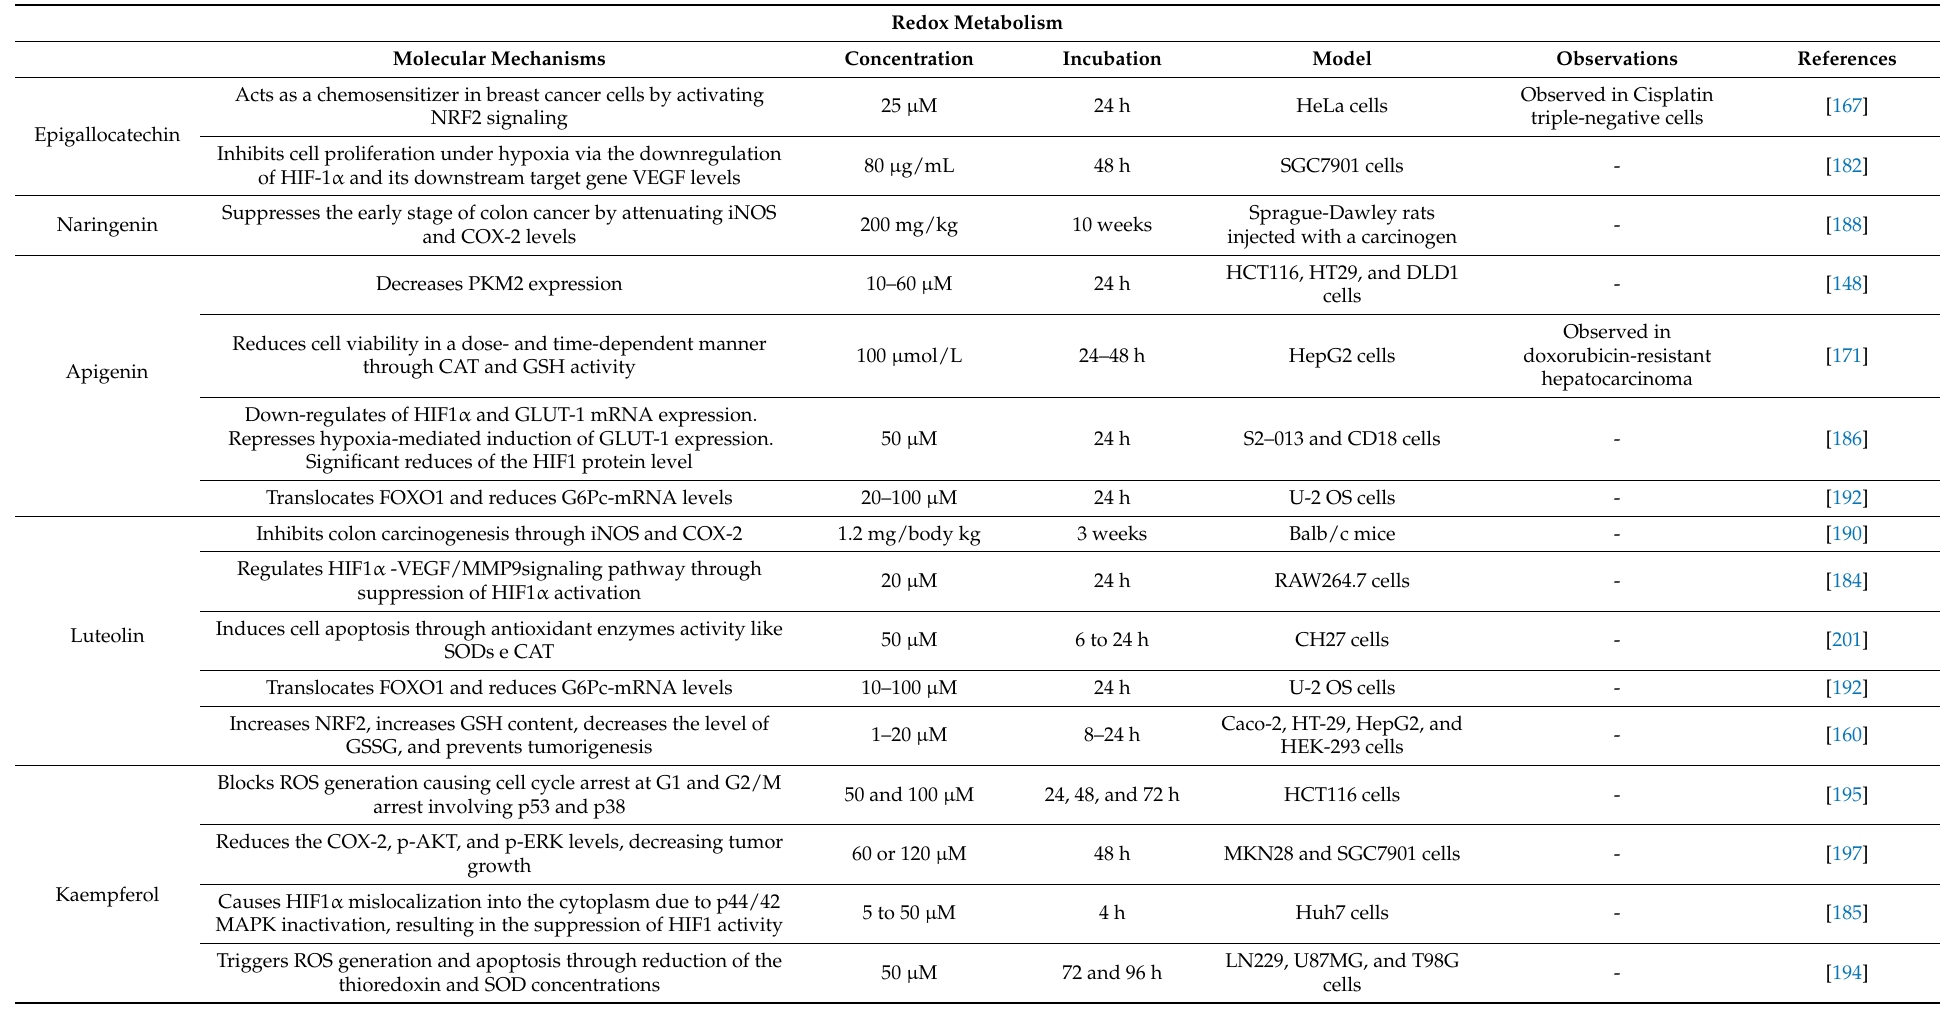
Table 4. Molecular mechanisms of flavonoids in redox metabolism and